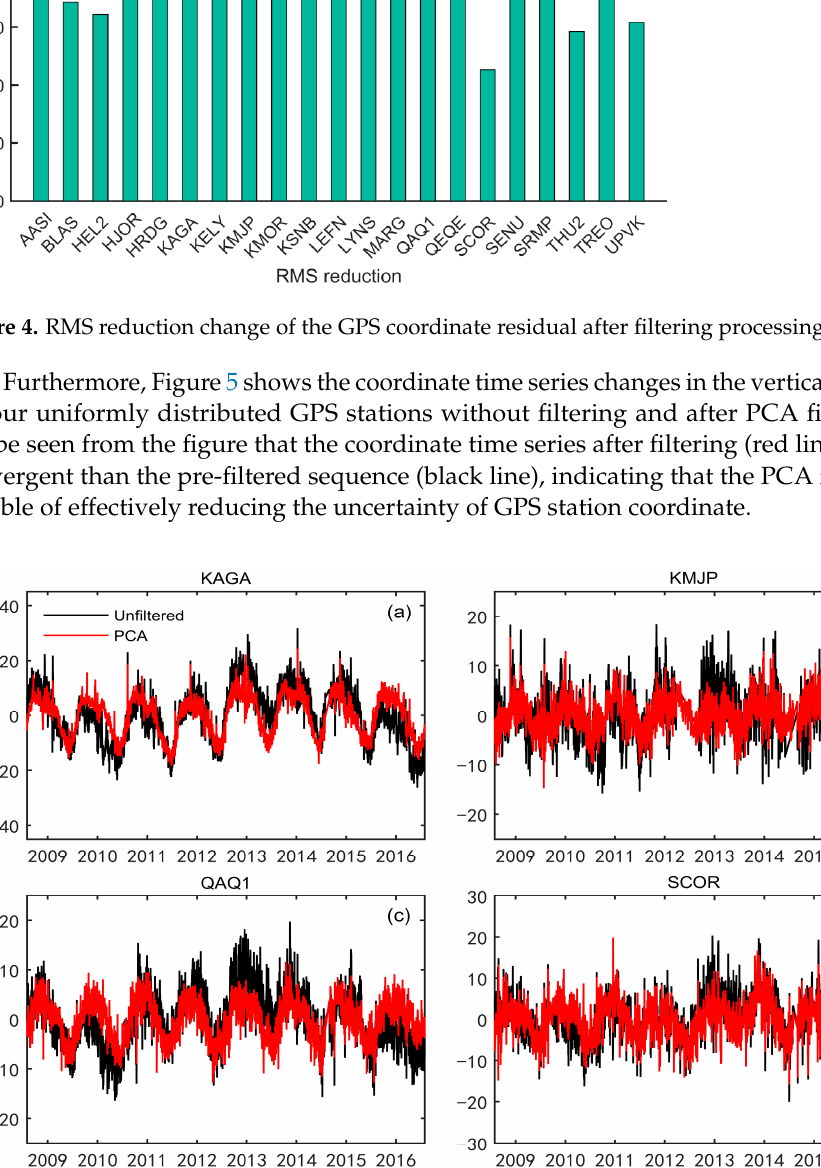
Figure 5. The GPS station time series changes before and after the CME filtering, where the black line represents the station data without filtering, and the red line represents the coordinate data after filtering.